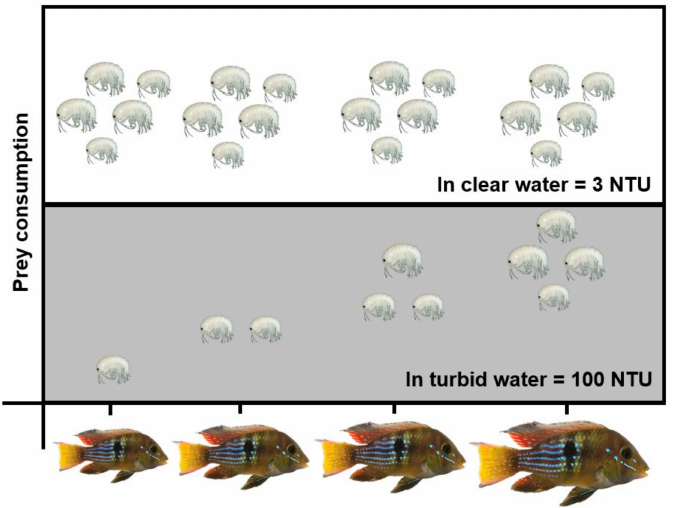
Figure 3. Conceptual figure highlighting that the prey consumption of Gymnogeophagus terrapurpura with di ff erent sizes was similar in clear water (white region), but that in turbid water (grey region) bigger fish had better foraging success than smaller ones. Therefore, we demonstrated that the e ff ects of increased turbidity on foraging success depend upon the predator body